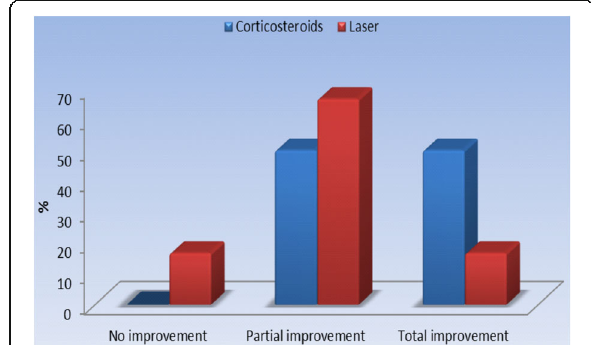
Fig. 3 Improvement percentage in the corticosteroid and laser